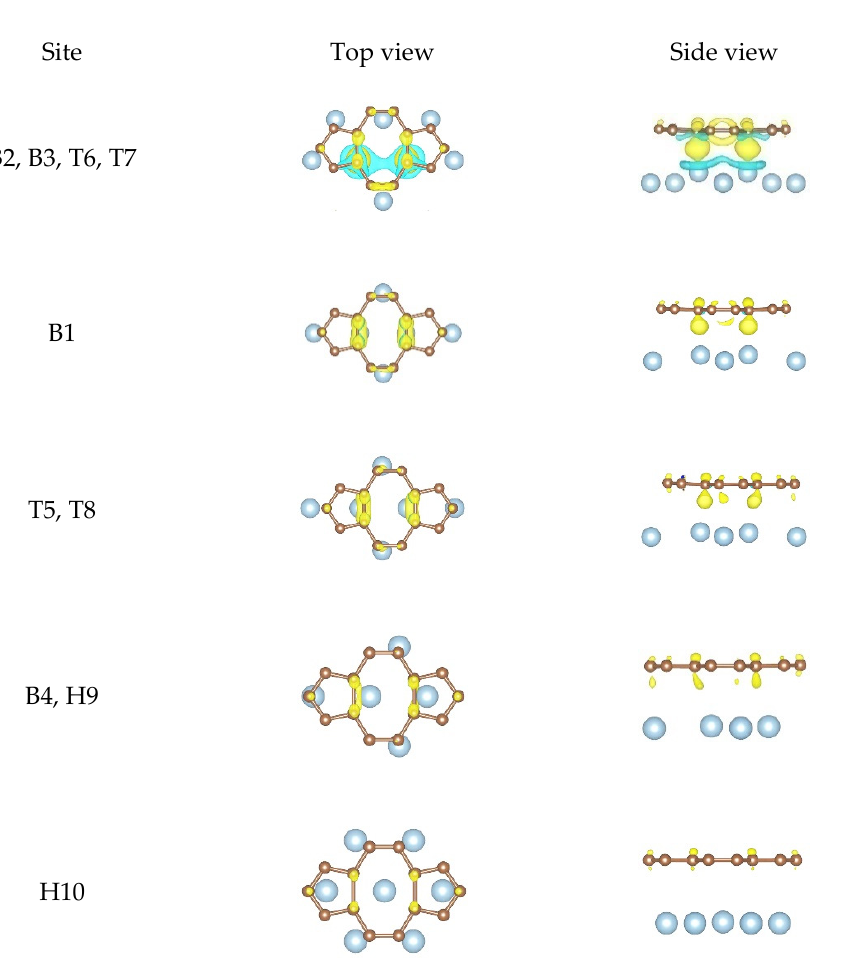
Figure 8. The local differential charge density plots at the DV graphene/Al (111) interface. The yellow/blue colors mark an increase/decrease of the charge density, respectively. Iso surfaces correspond to 3 × 10 − 3 e/Å 3 .